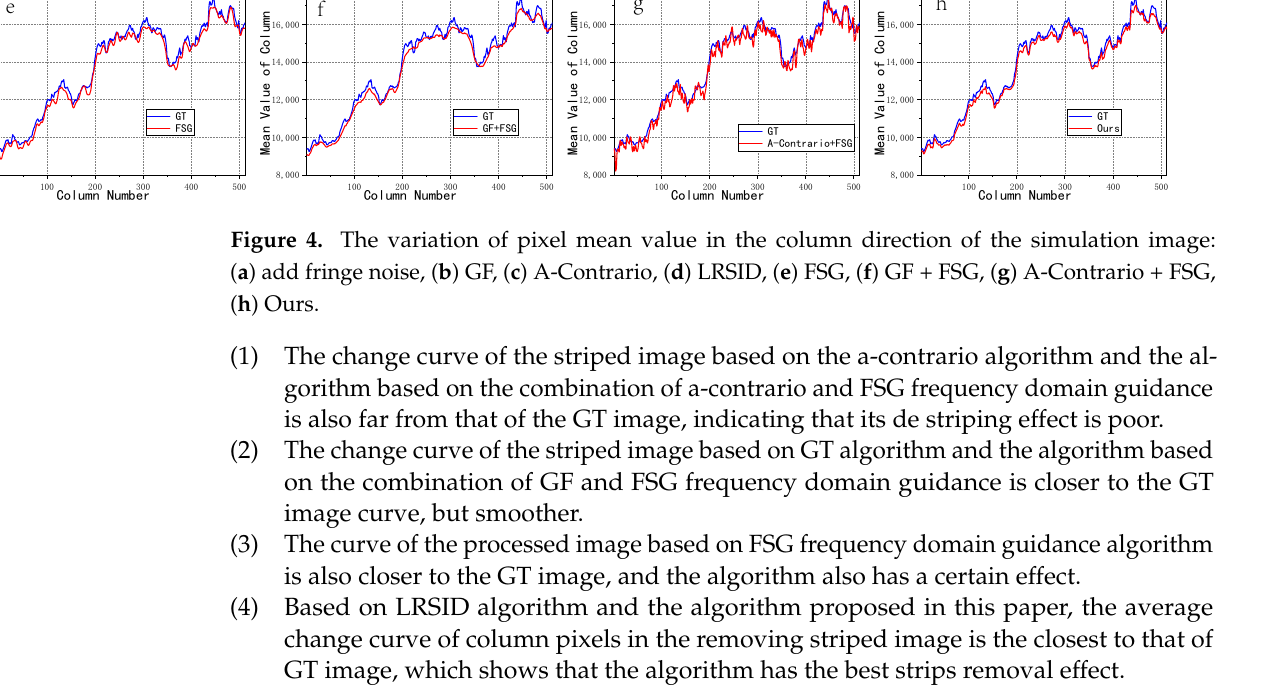
For the striped image, the image processed based on a ‐ contrario algorithm and the algorithm based on the combination of a ‐ contrario and FSG frequency domain guidance has the best sharpness, but the effect of de striping is poor. Compared with the LRSID algorithm, which has a better effect of removing fringes, the algorithm proposed in this paper can greatly improve the image definition, and can achieve a better effect of Table 1. Comparison of quantitative indexes of simulation image processing results. removing fringes while retaining the details of the image.